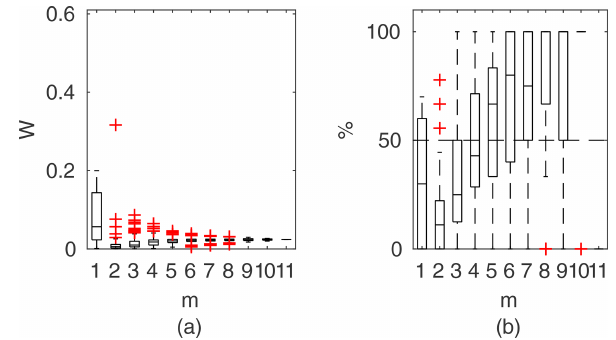
Figure B18. Manning DCM results for the Ritobacken case study, spring 2012: (a) averaged relative confidence widths W as a func- tion of observation set size m used for model identification; (b) per- centage of verification points enclosed by the confidence inter- vals (100% denotes all points within intervals, box spans over the 25% and 75% quantiles, the median is given with horizontal line, whiskers indicate the result extent, and cross marks are for extreme values).